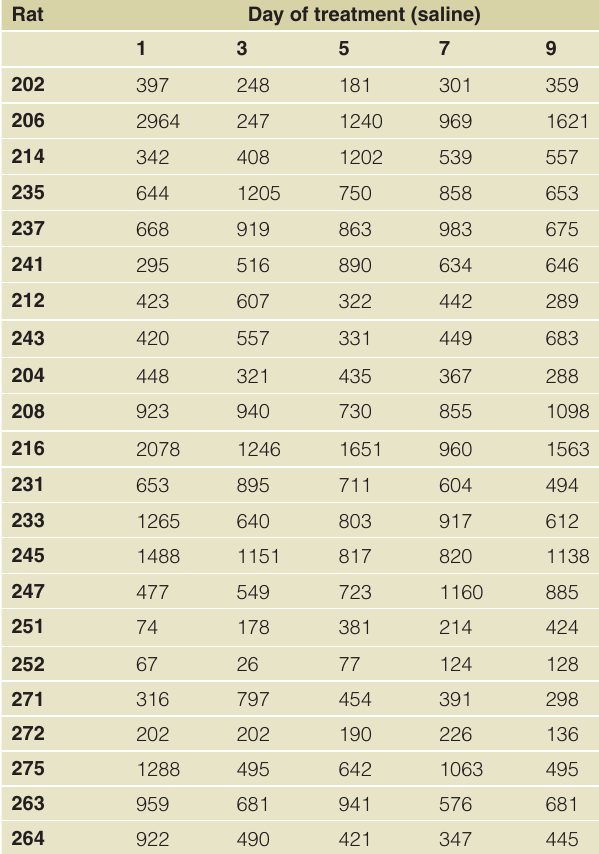
Table S2. CDPPB experiment – locomotor response (total quarter turns over 90 min) after saline treatments. In locomotor sessions prior to mGluR5-targeted treatment, rats were chronically given 1 ml/kg saline i.p. The reported quarter turns did not significantly change from first-day